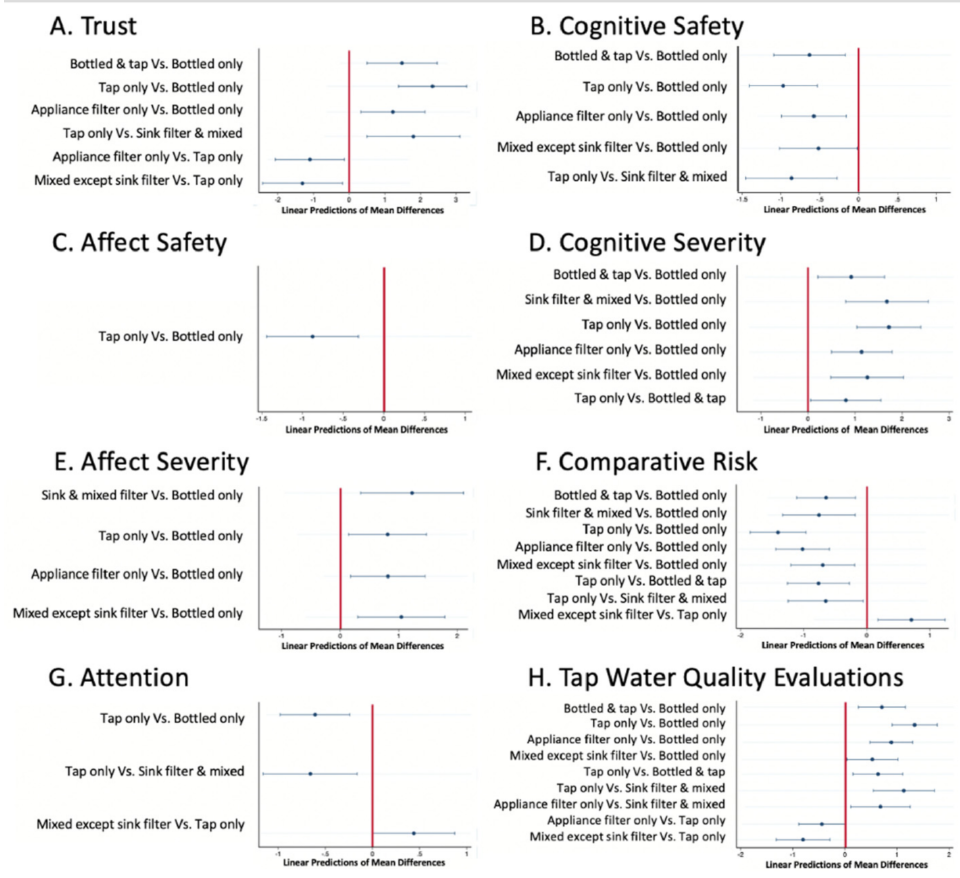
Figure 4. Post hoc pairwise comparisons of adjusted linear predictions of mean differences (first cluster–second cluster) between clusters for each predictor variable. Predictions were calculated using a Bonferroni test with 95% confidence intervals. Only significant differences at a p < 0.05 level are